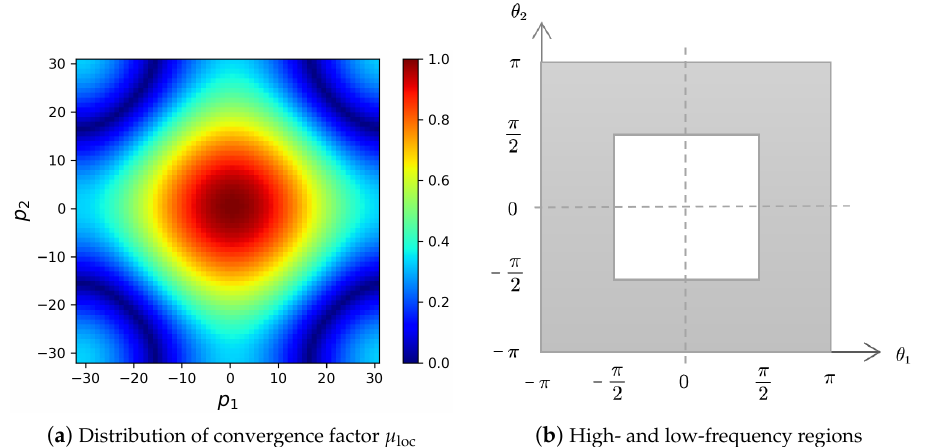
Figure 1. ( a ) Distribution of the convergence factor µ loc of the weighted Jacobi method ( ω = 2/3) in solving a linear system arising from the Poisson equation; ( b ) Low-frequency (white) and high- frequency (gray)